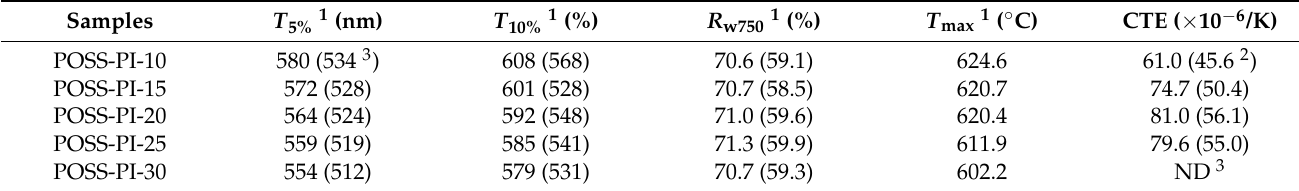
Table 3. Thermal properties of POSS-PI composite films.